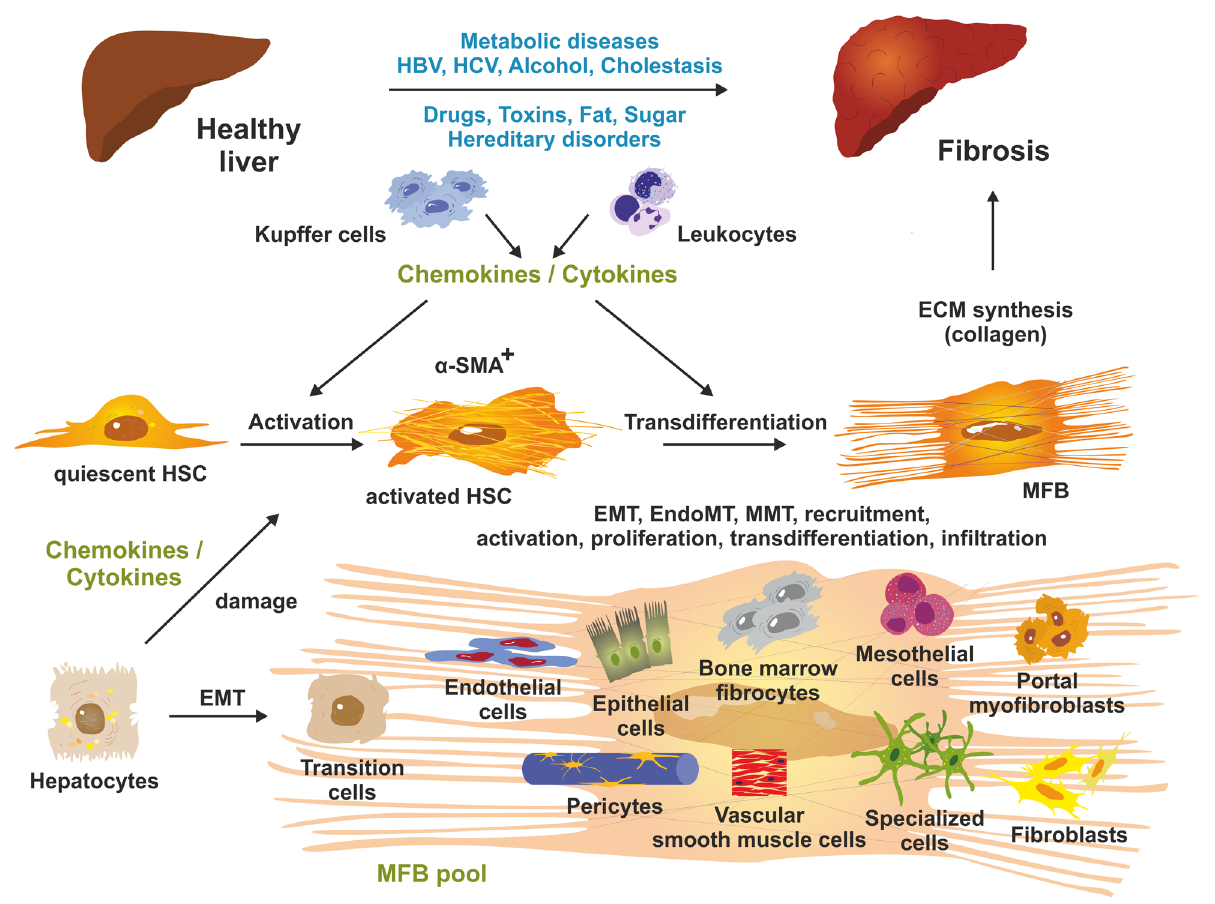
Figure 1. Pathogenesis of hepatic fibrosis. Prolonged liver injury results in changes in hepatic architecture and advanced fibrosis. At the cellular level, quiescent hepatic stellate cells (HSCs) become triggered by soluble mediators (chemokines and cytokines) released by liver- resident macrophages (Kupffer cells), infiltrating leukocytes, and other cell types including damaged hepatocytes. Both activated HSCs and transdifferentiated myofibroblasts (MFBs) are positive for α -smooth muscle actin ( α -SMA). MFBs are the predominant source of collagen synthesis and deposition. The pool of extracellular matrix (ECM)-producing MFBs is further increased by different cell types such as resident fibroblasts, mesothelial cells, circulating (bone marrow) fibrocytes, epithelial cells, endothelial cells, pericytes, vascular smooth muscle cells, and other specialized cell types that acquire pro-fibrogenic activities and become capable of expressing ECM components. The relevant molecular and cellular mechanisms including epithelial-to-mesenchymal transition (EMT), endothelial-to-mesenchymal transition